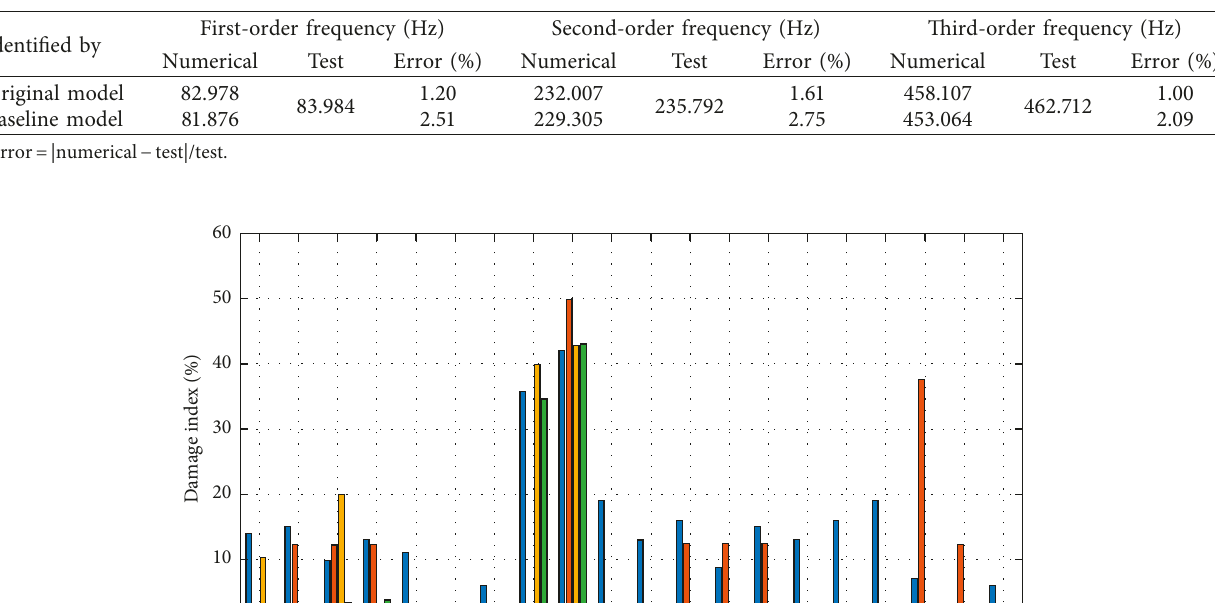
Table 9: Frequencies of the damaged beam.